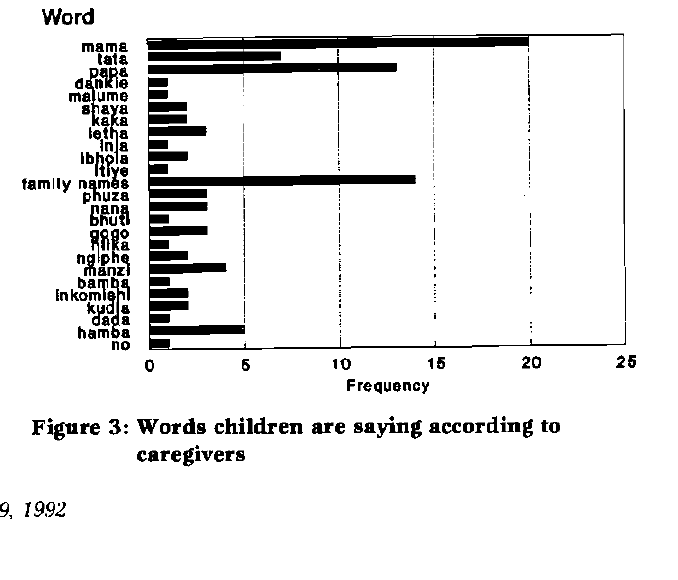
Figure 3: Words children are saying according to